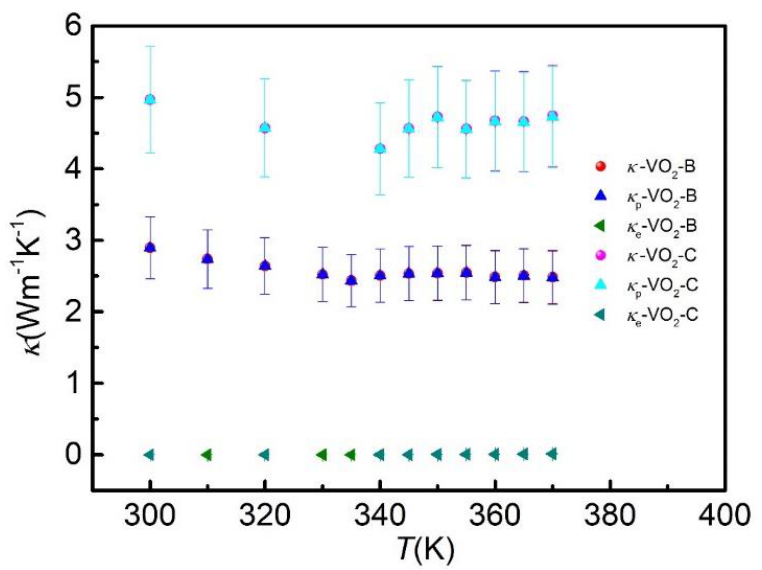
Figure 4. The total thermal conductivity ( κ , red circles and magenta circles), phonon thermal conductivity ( κ p , blue triangles and cyan triangles) and electronic thermal conductivity ( κ e , olive triangles and dark cyan triangles) of the VO 2 nanowire samples as a function of temperature for VO 2 -B and VO 2 -C, respectively.